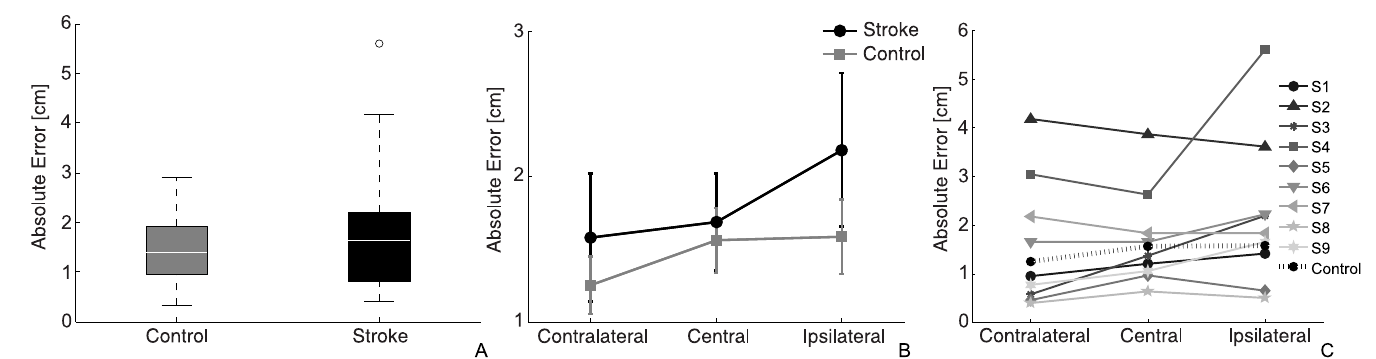
Fig 2. Absolute errors. (A) Box-plot of absoluteerrors for the two groups. (B) Mean absoluteerrors in the 3 directionsfor the two groups, where the gray squaresrepresent data from the control group and black circles represent stroke patients. (C) Absoluteerrors for each patient and mean value of the control